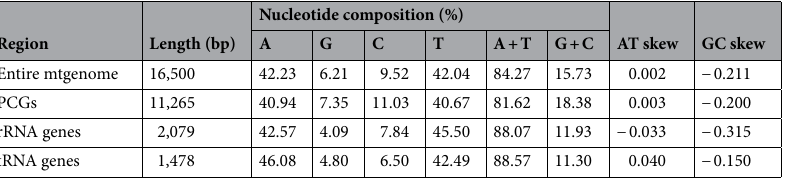
Table 2. The length, nucleotide composition, and AT/GC skewness of the Euxiphydria potanini mtgenome.